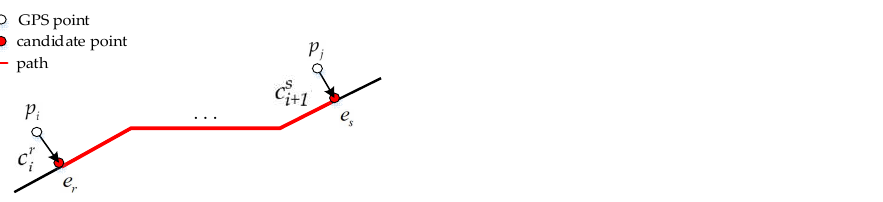
on e r to the candidate point c s i . i+ (cid:2869)